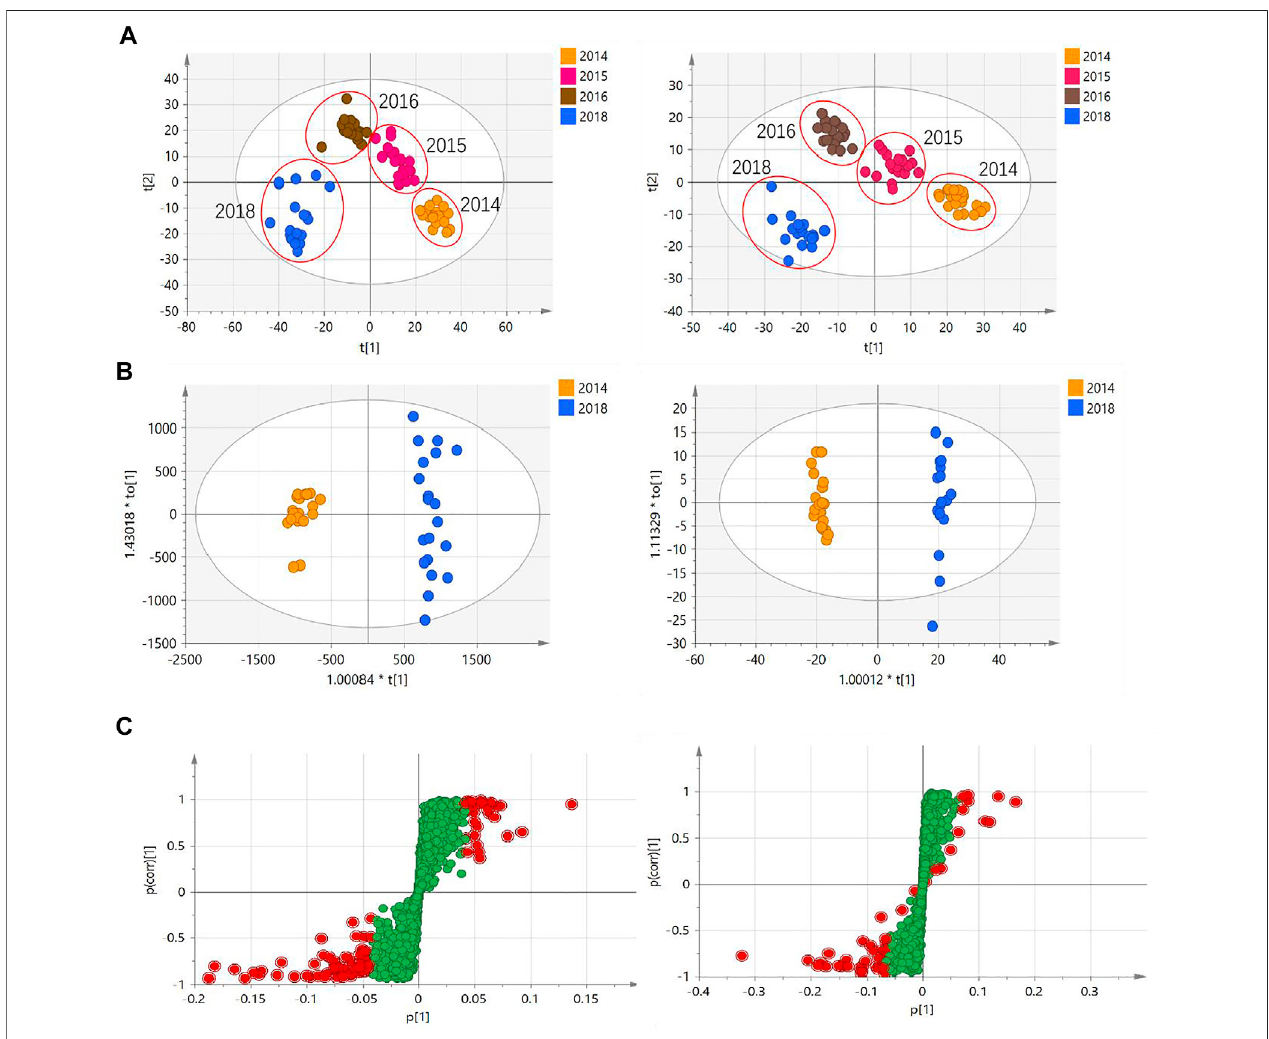
FIGURE2|(A) PLS-DAscoreplotsofCHS-Jsampleswithdifferentproduction yearsinpositive(left)andnegative (right)ionmodes. (B) OPLS-DAscoreplotsand (C) their S -plots of CHS-J samples produced in 2014 and 2018 detected in positive (left) and negative (right) ion modes.